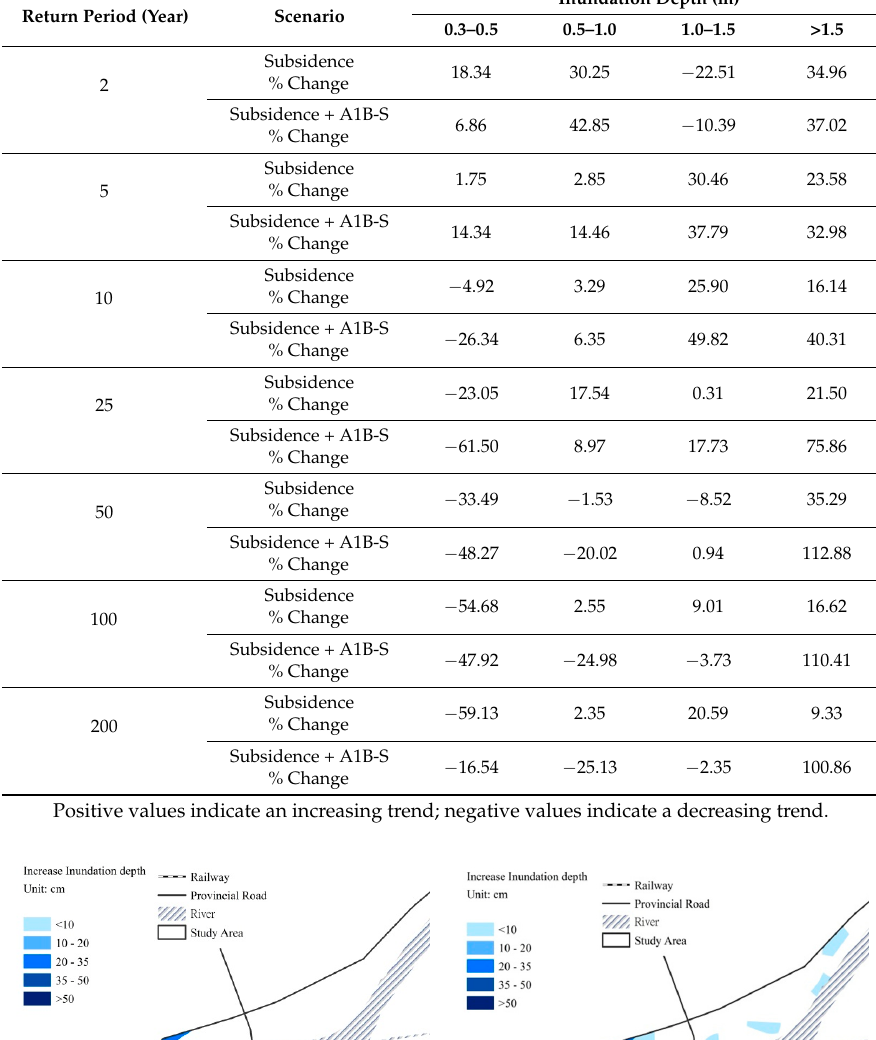
Table 8. Percentage of inundation volume increase for two-day storm under different return periods and scenarios.